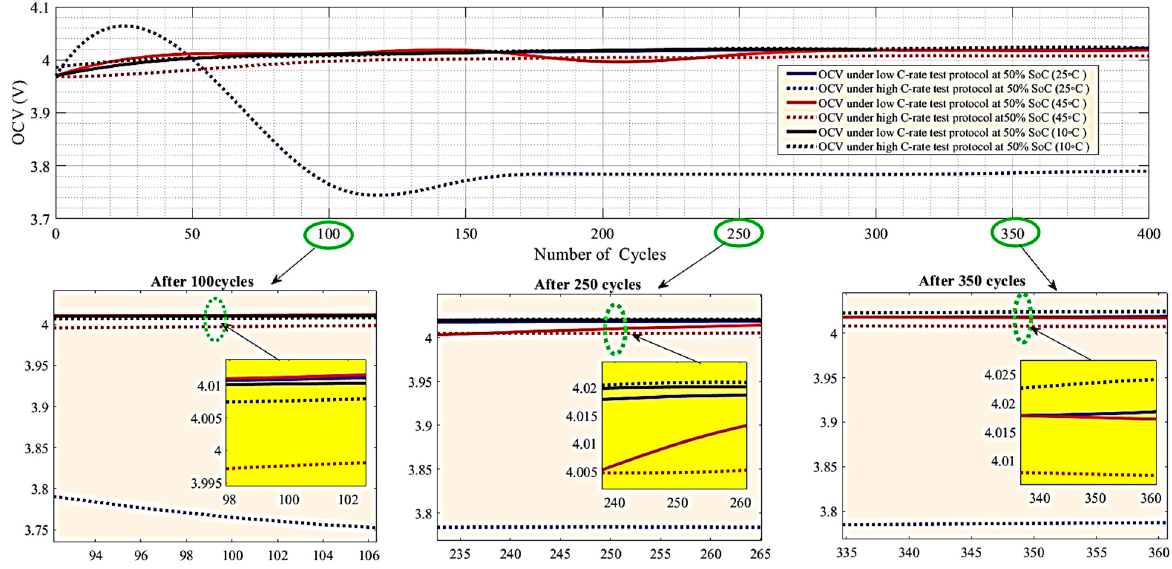
Figure 16. Behavior of OCV at 10 °C, 25 °C, and 45 °C under high and low discharge tests during the lifetime of the battery at 50% SoC.